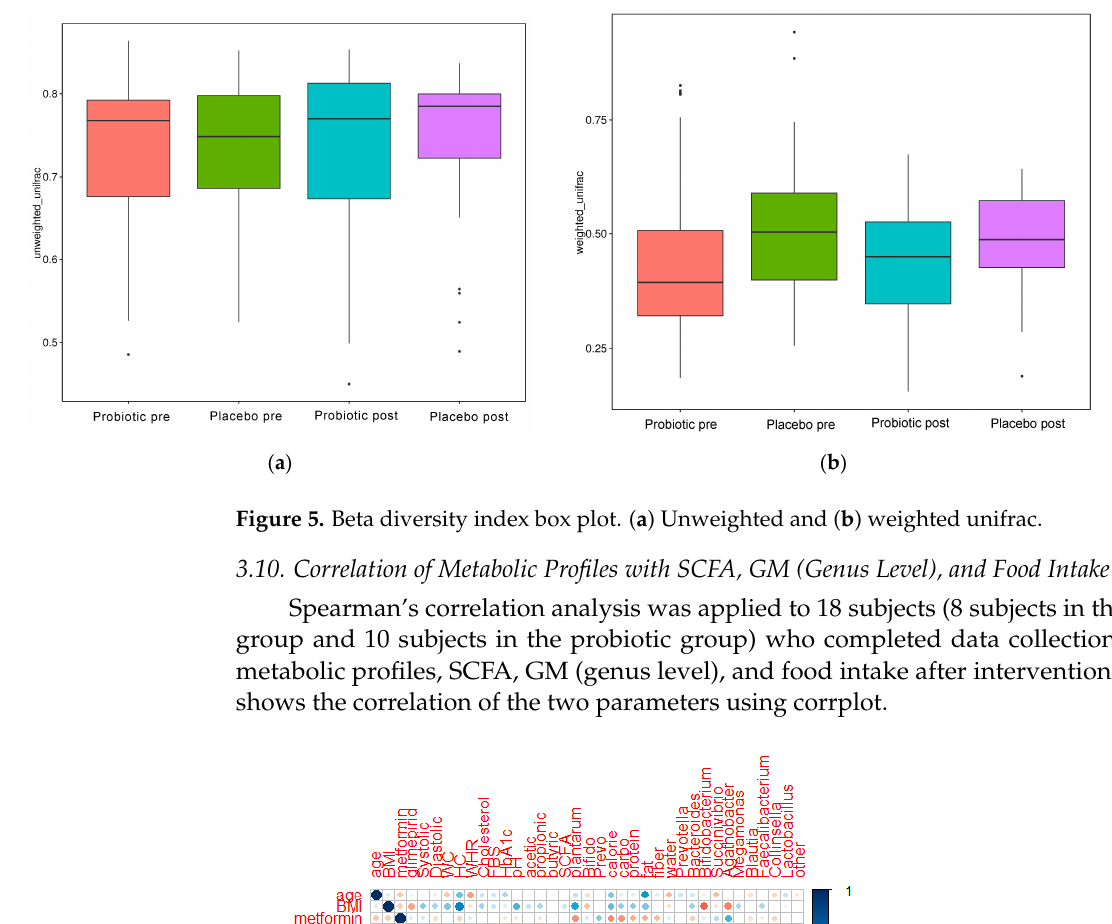
Figure 4. Alpha diversity boxplot index. ( a ) Observed species, ( b ) Chao1, ( c ) Shannon, and ( d ) Simpson.